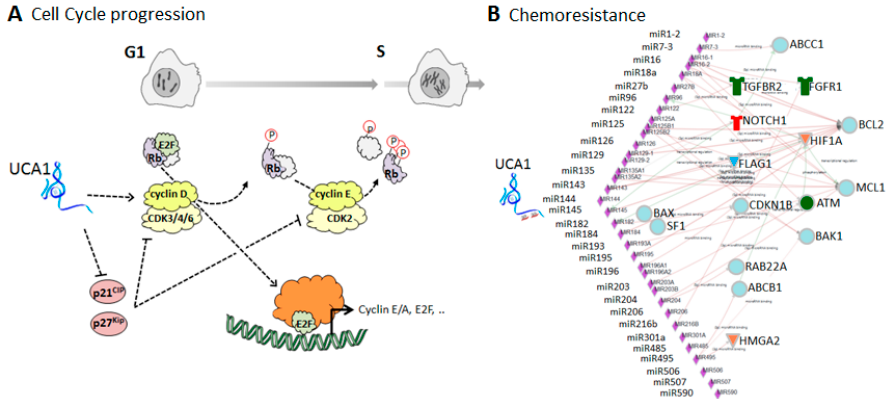
Figure 3. The UCA1-mediated regulation in colorectal cancer cells. (A) Schematically representation of UCA1 regulating key actors for cell cycle progression during G1 and S-phase in diverse cancer cell types. (B) All 29 miRNAs published to interact with UCA1 in diverse cancer cell types (Table 4) were